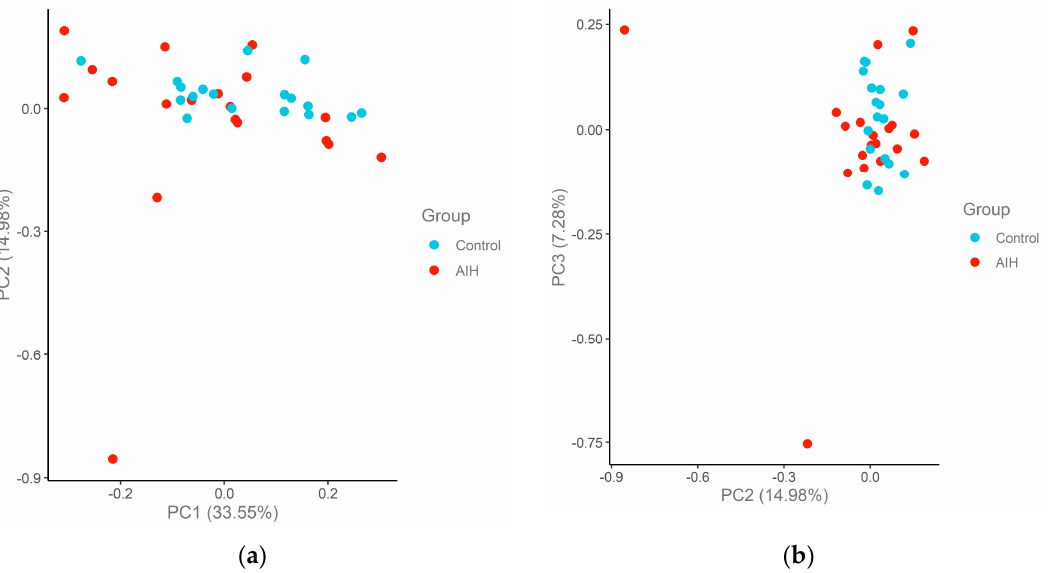
Figure 2. Principal component analysis (PCA) plots of the AIH and control cohort samples in the Cardiometabolic panel. The samples are colored according to the group. The percentage of variation that accounted for each principal component is shown in brackets along the x and y axis label. ( a ) PC1−PC2; ( b ) PC2−PC3.